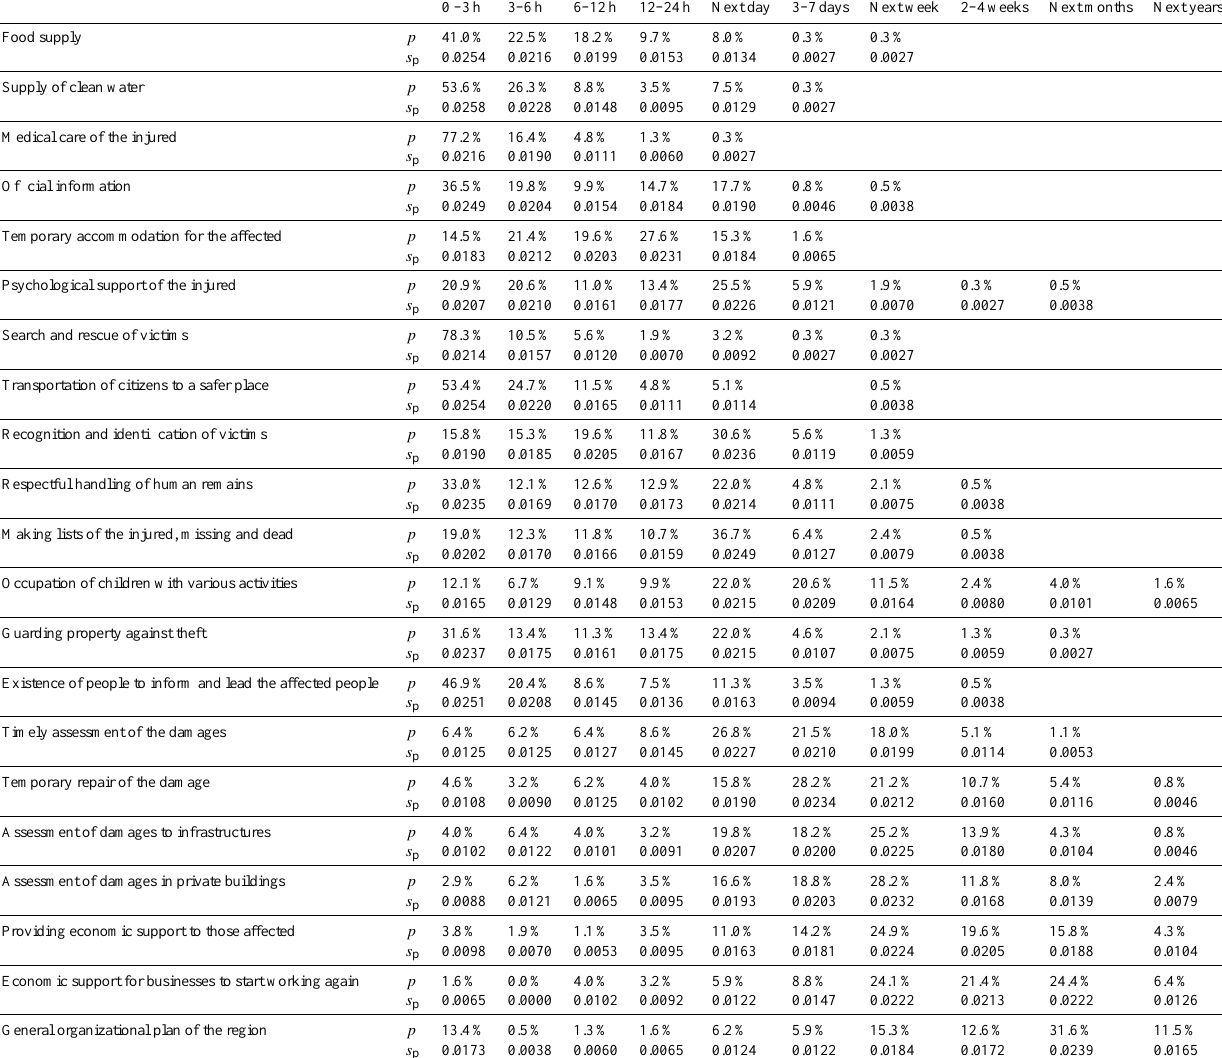
Table 2. Residents’ opinions and attitudes about what is most necessary to be done, chronologically, after an extreme natural